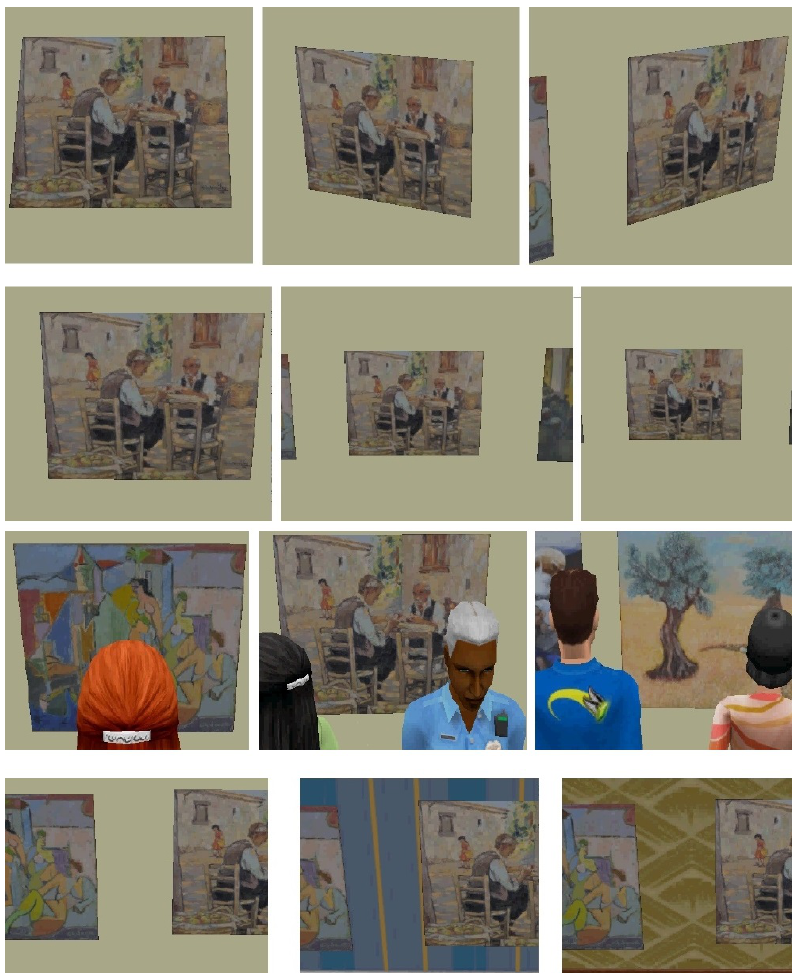
Figure 3. Samples showing examples of different conditions simulated in the virtual